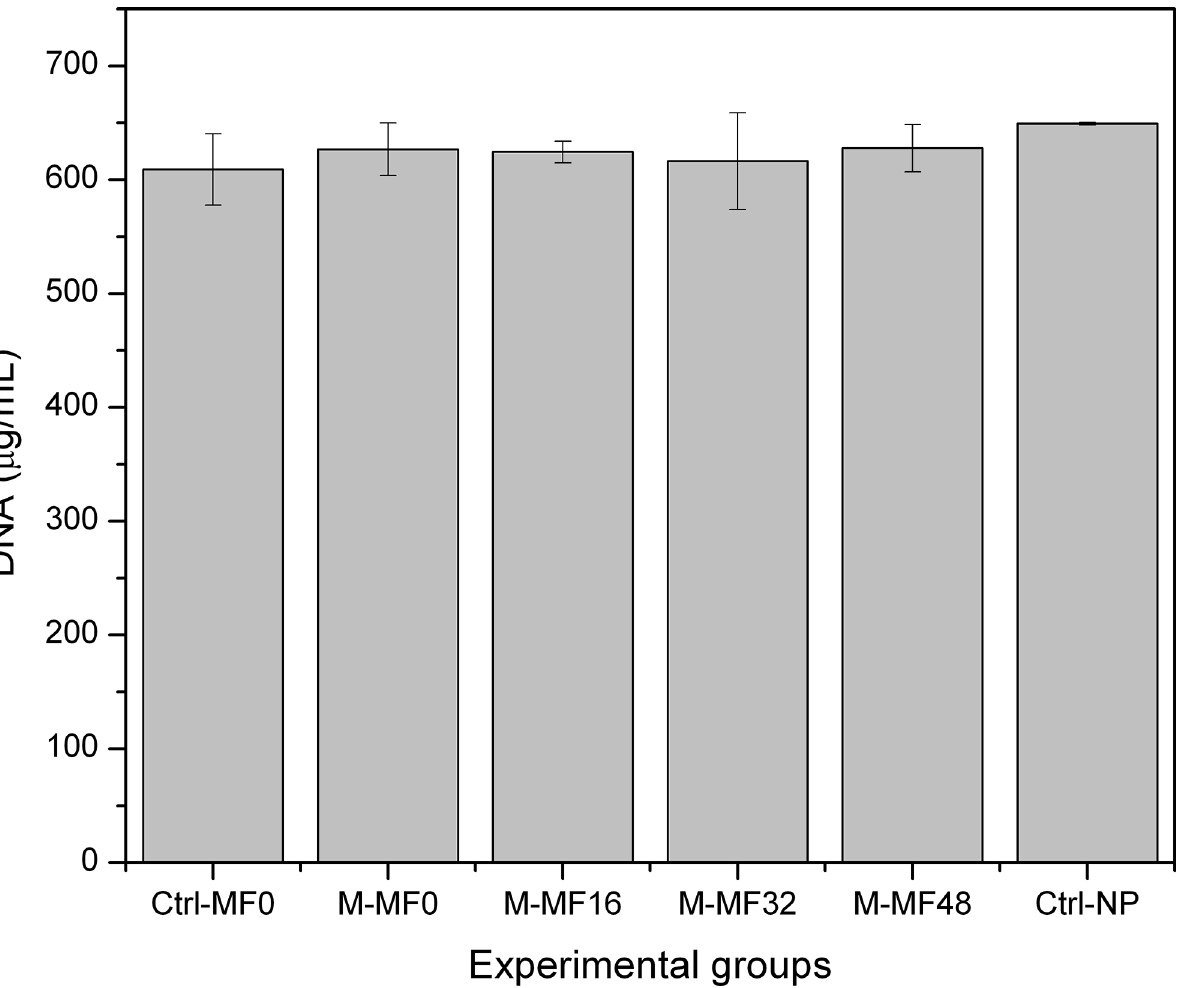
Fig 3. Quantification of DNA release. Integrity of the nuclear membrane was studied by quantifying the DNA released in the culture medium. The graph shows the mean values ± standard deviations of 8 independent experiments for each experimental group. Ctrl-MF0: control (nonmagnetic) tissue substitute without particles, gelled in the absence of a magnetic field; Ctrl-NP: control (nonmagnetic) tissue substitute with nonmagnetic polymer particles; M-MF0: magnetic tissue substitute gelled in the absence of a magnetic field; M-MF16, M-MF32 and M-MF48: magnetic tissue substitutes gelled during application of a 16 kA m -1 , 32 kA m -1 or 48 kA m -1 field,